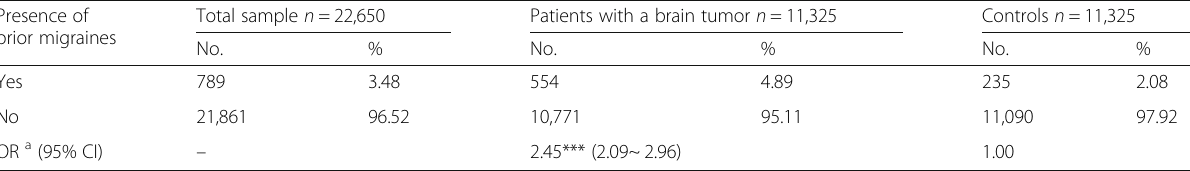
Table 2 Odds ratios (ORs) of prior migraines among patients with a brain tumor and the controls ( n = 22,650) Presence of Total sample n = 22,650 Patients with a brain tumor n = prior migraines